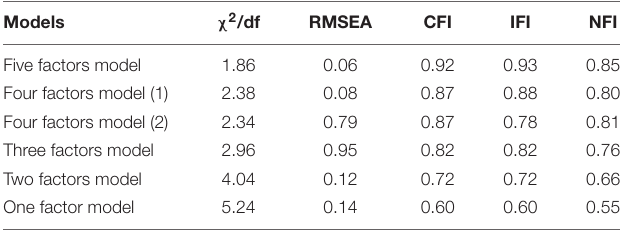
TABLE 1 | The result of confirmatory factor analysis of the model.